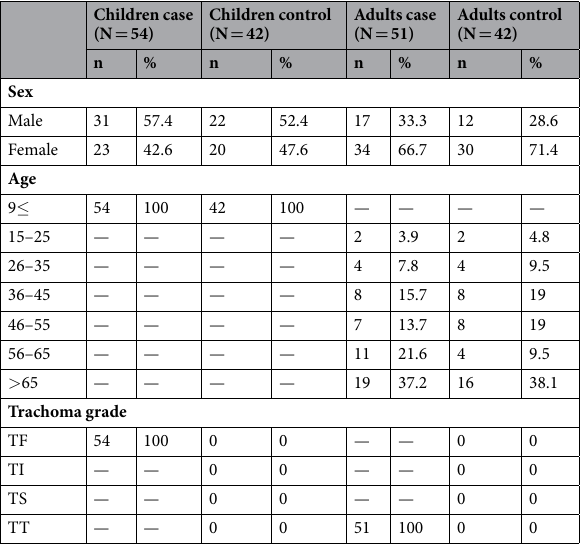
Table 1. Baseline and clinical characteristics of study participants in Al